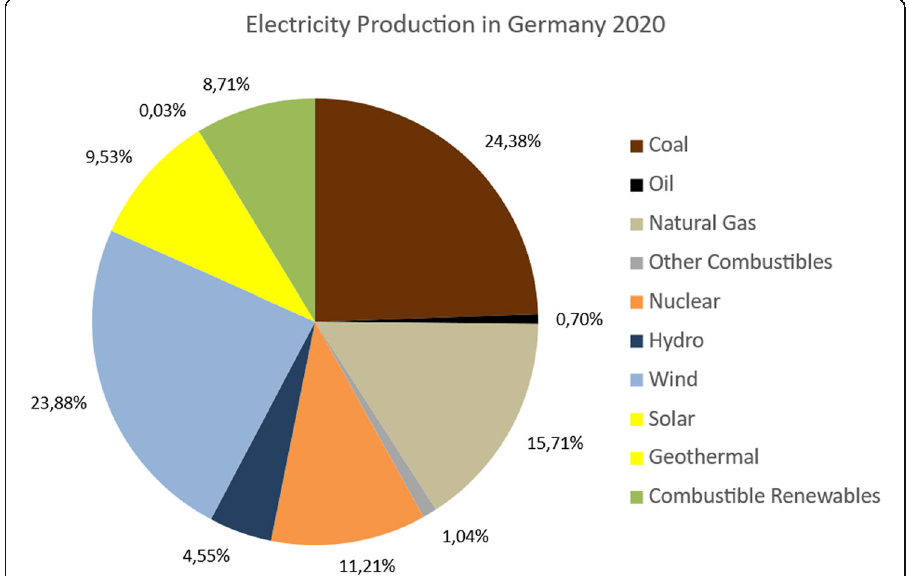
Fig. 2 Electricity Production share by source in Germany 2020 (Own illustration based on data from (International Energy Agency